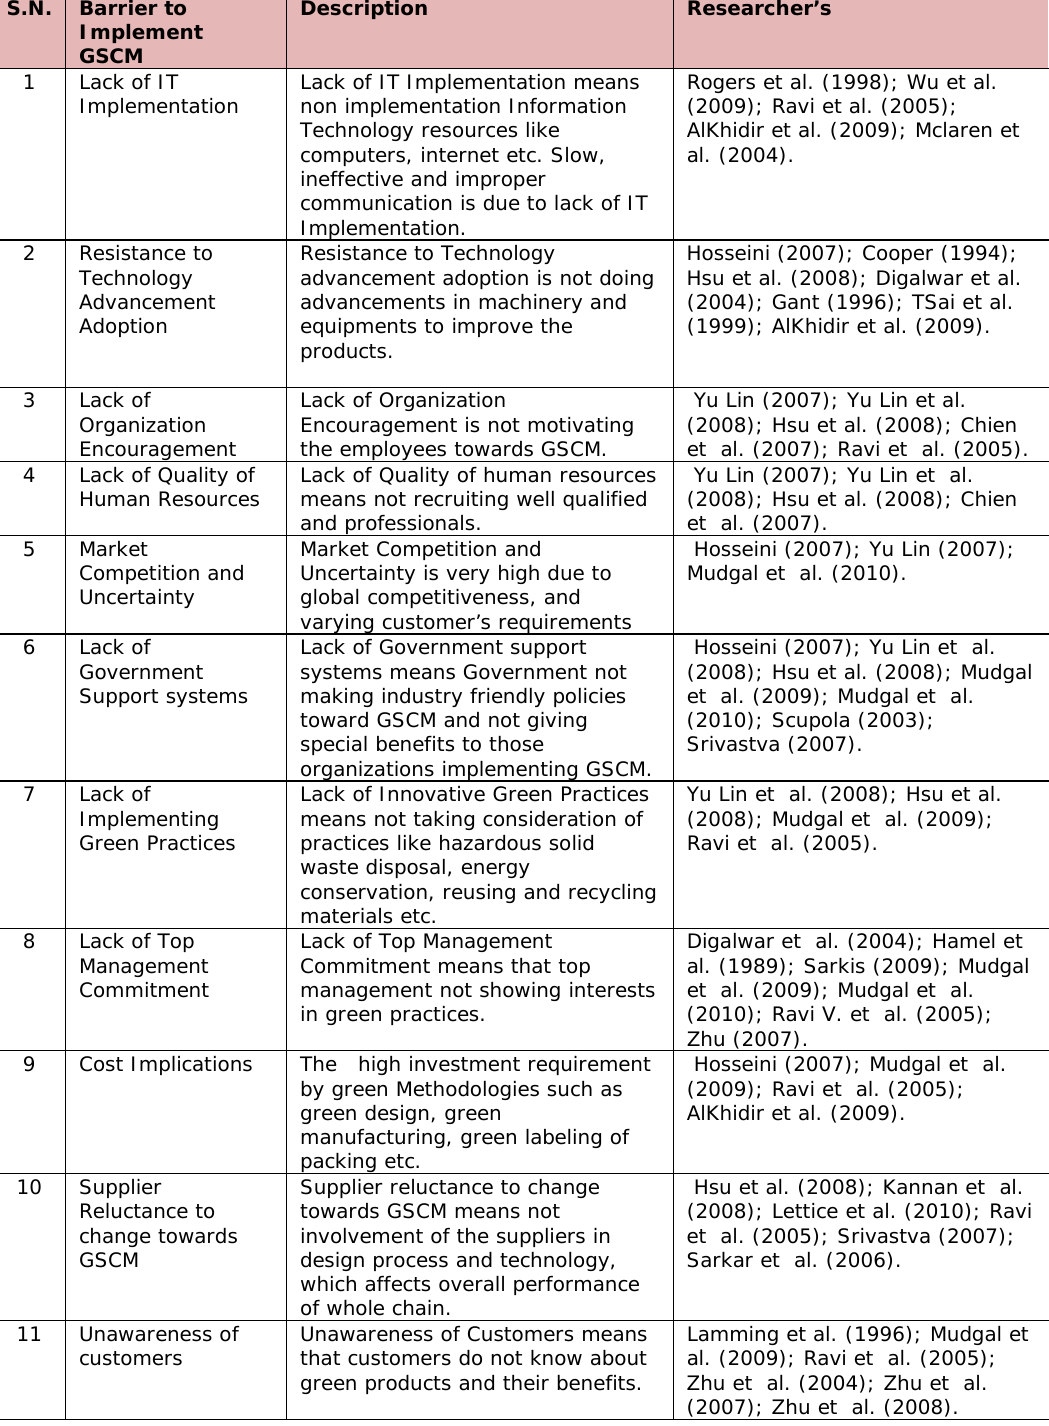
Table 2. “Barrier to Implement GSCM in Indian Automobile Industry reported in